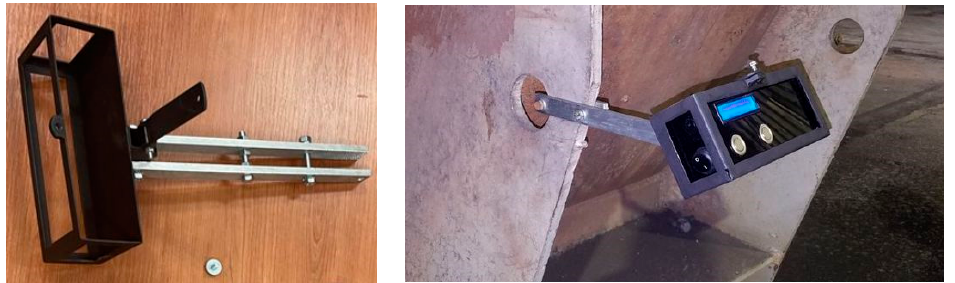
Figure 9. Installation of acquisition device: bracket for device accommodation ( left ); device mounted on the industrial coal mill ( right ).